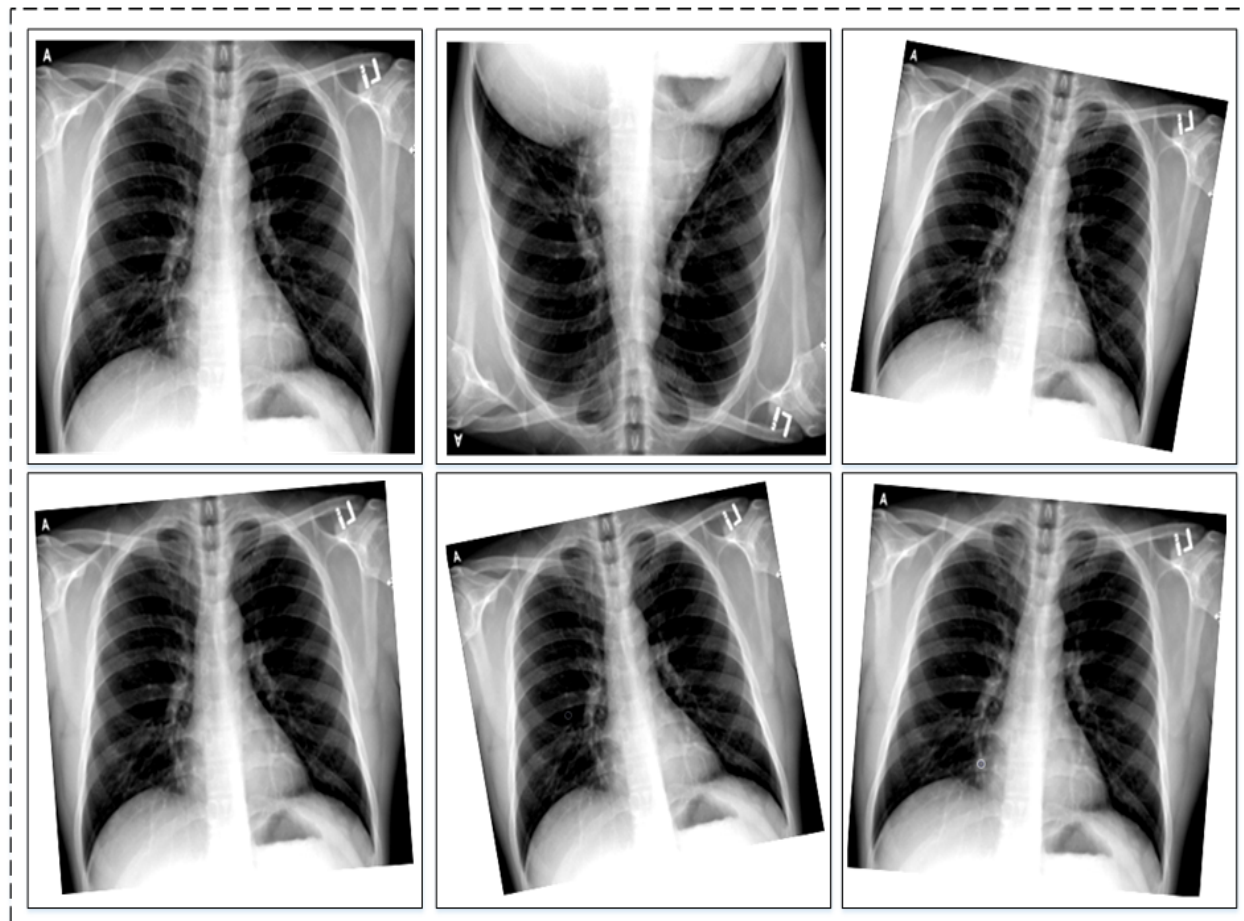
Figure 3. Sample images of original dataset after performing data augmentation .